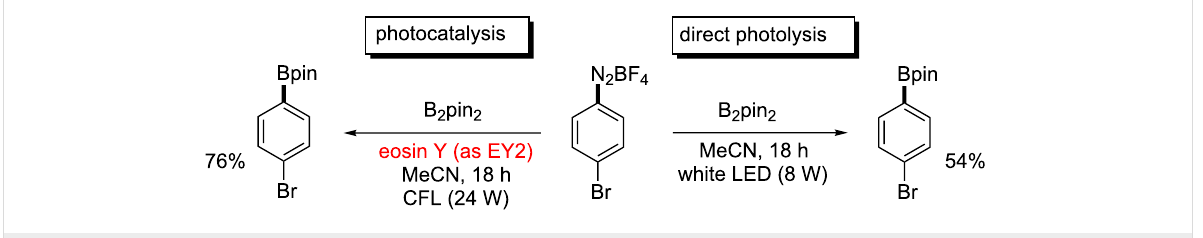
Scheme 4: Eosin Y-catalyzed and dye-free photolytic borylation.